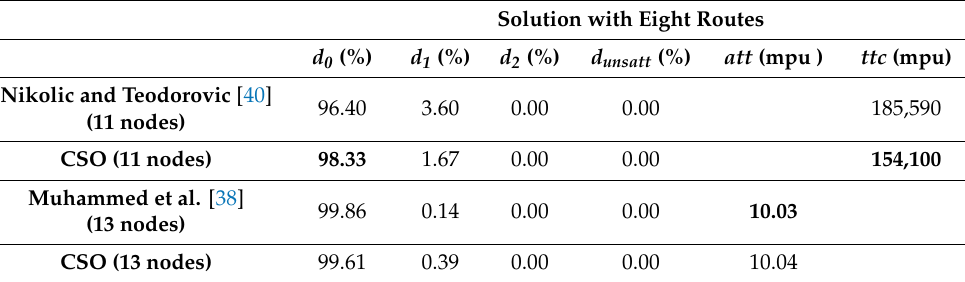
Table 12. Comparative results for the best eight-route solutions for Mandl’s network. Solution with Eight